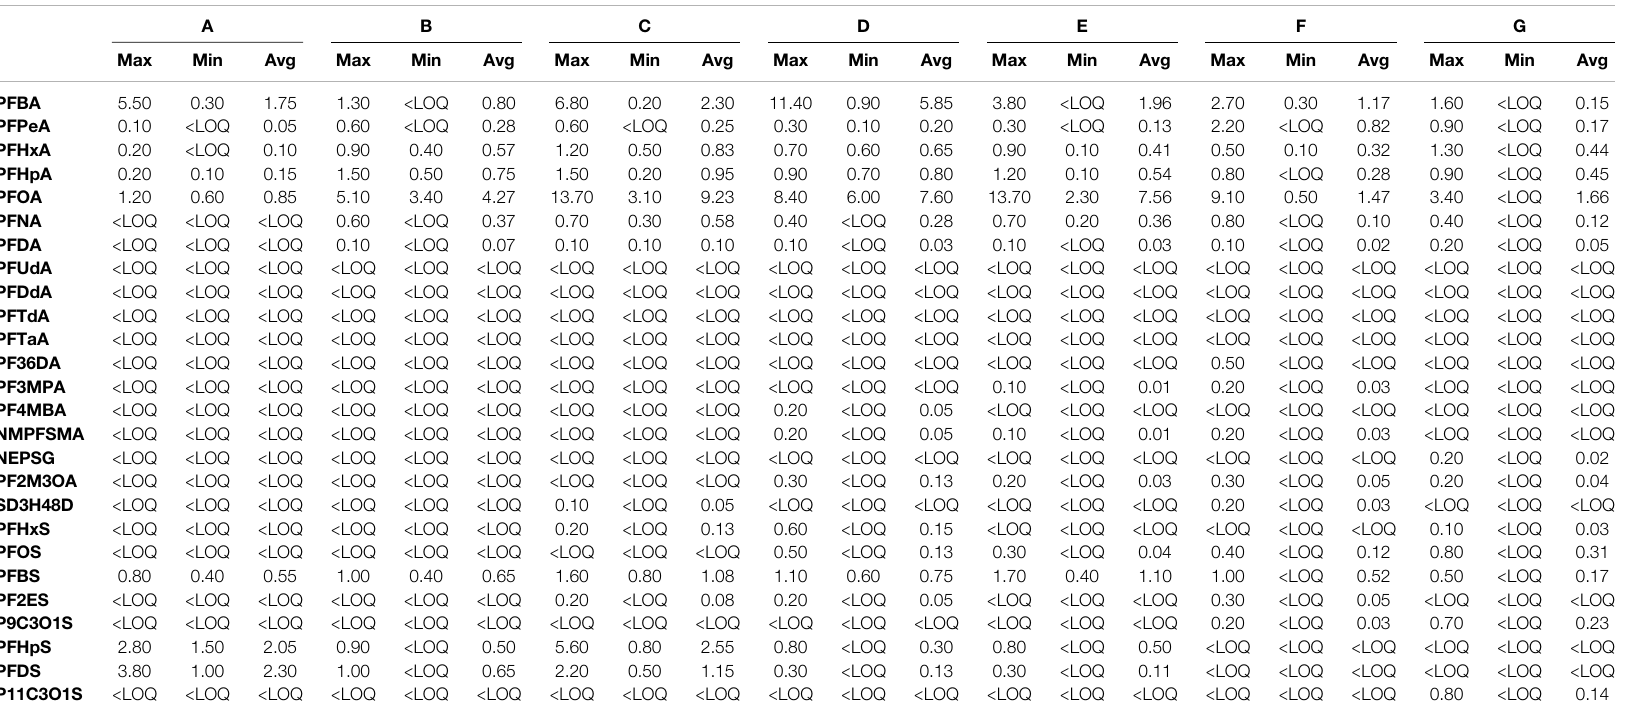
TABLE 1 | Concentrations of PFASs in 7 reservoirs (unit: ng L − 1